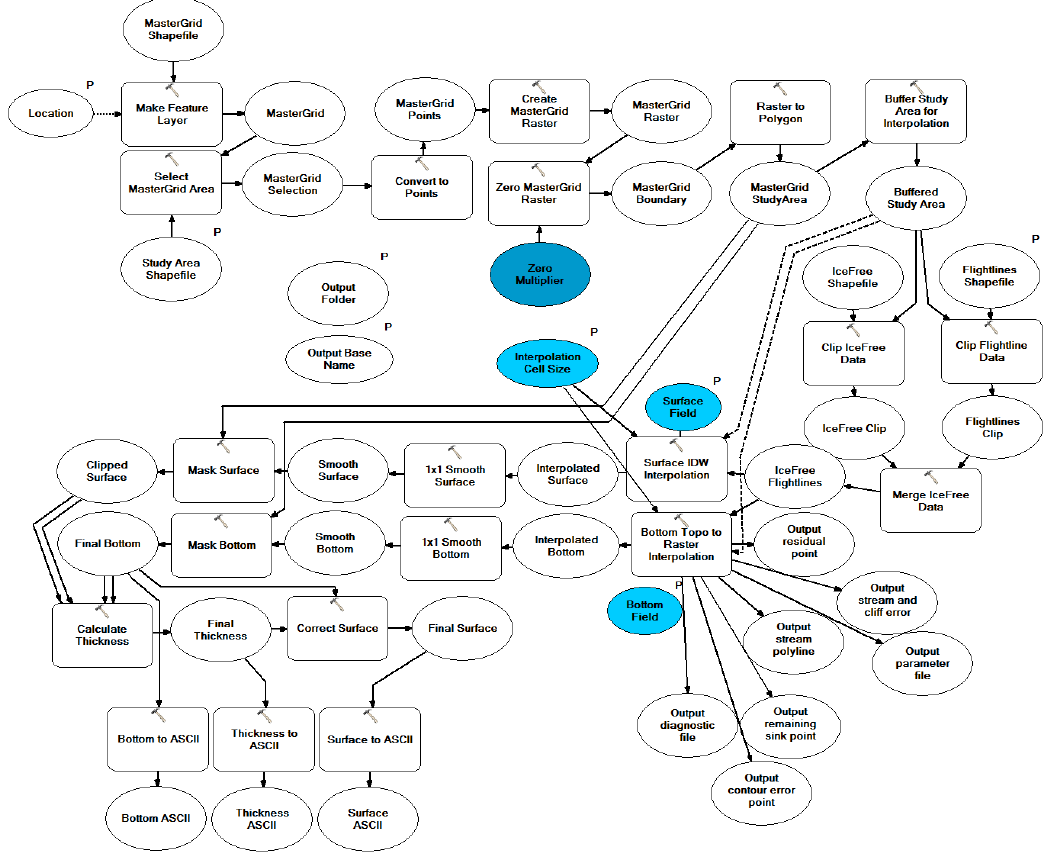
Figure 11. Model for the interpolation tool of CReSIS data.